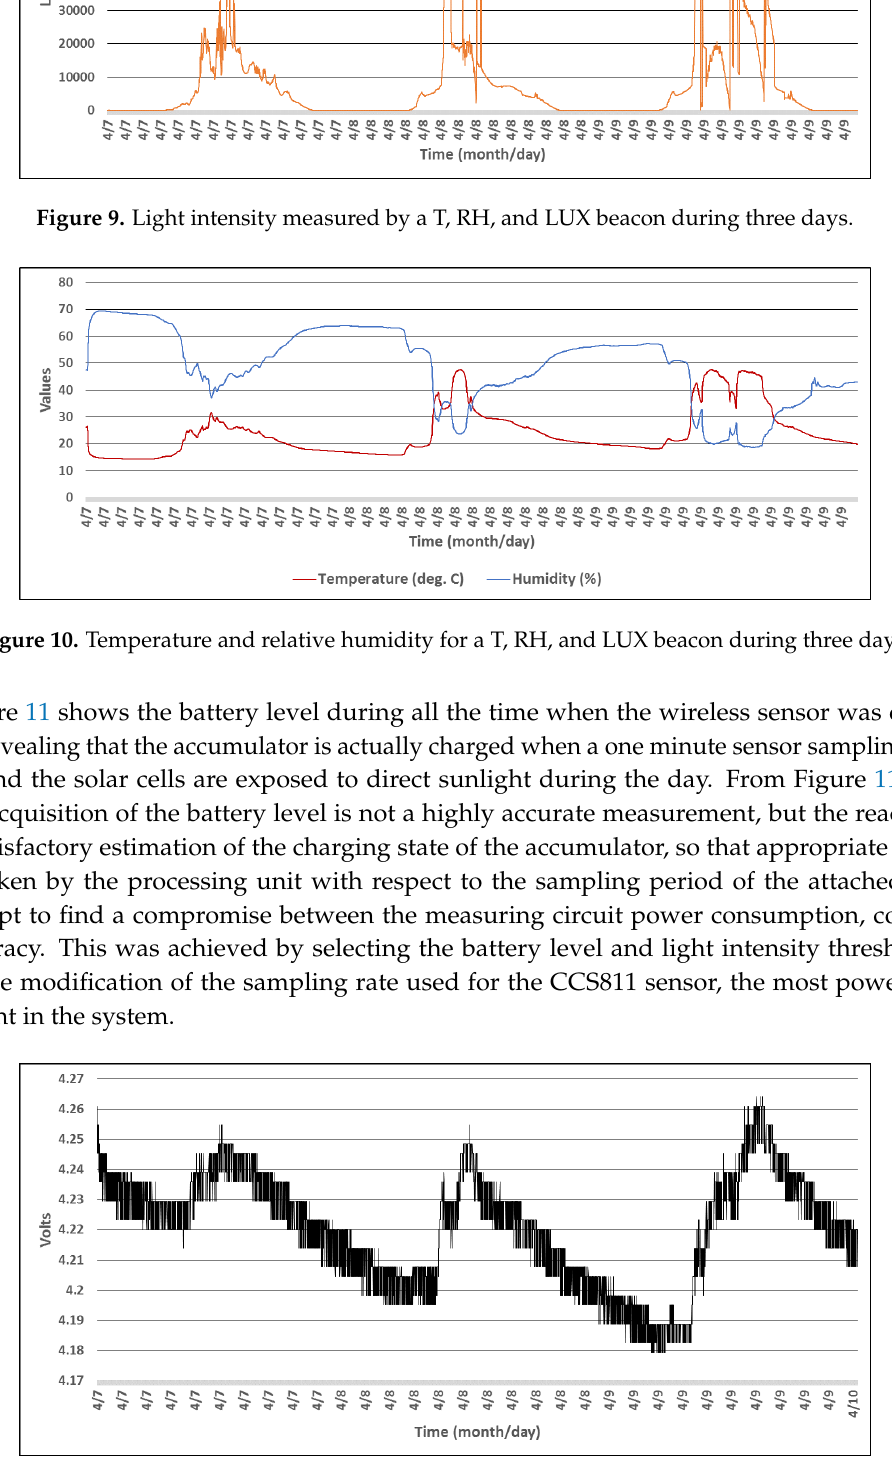
Figure 11. Accumulator level for a T, RH, and LUX beacon during three